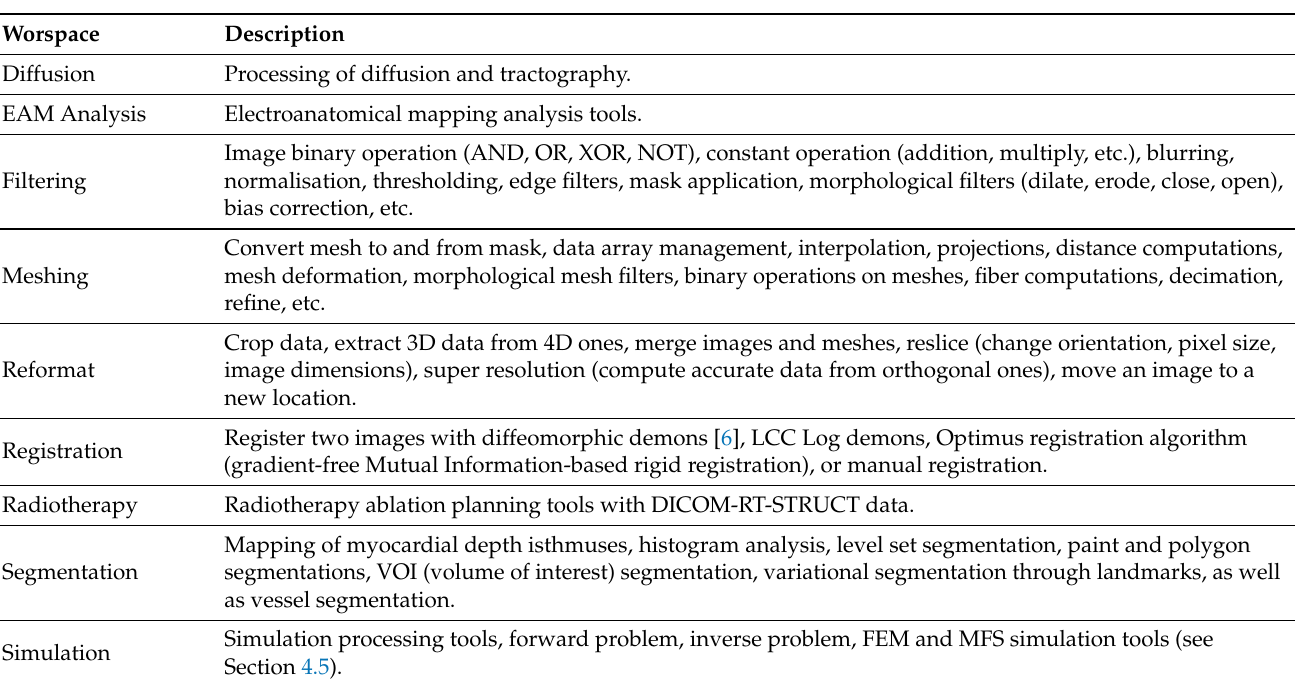
Table 3. List of the main imaging and meshing tools in MUSICardio.